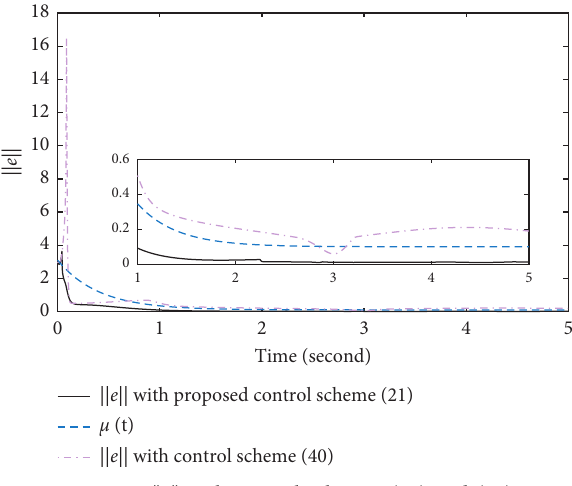
, e , and x with proposed control scheme (20). 1 2 3